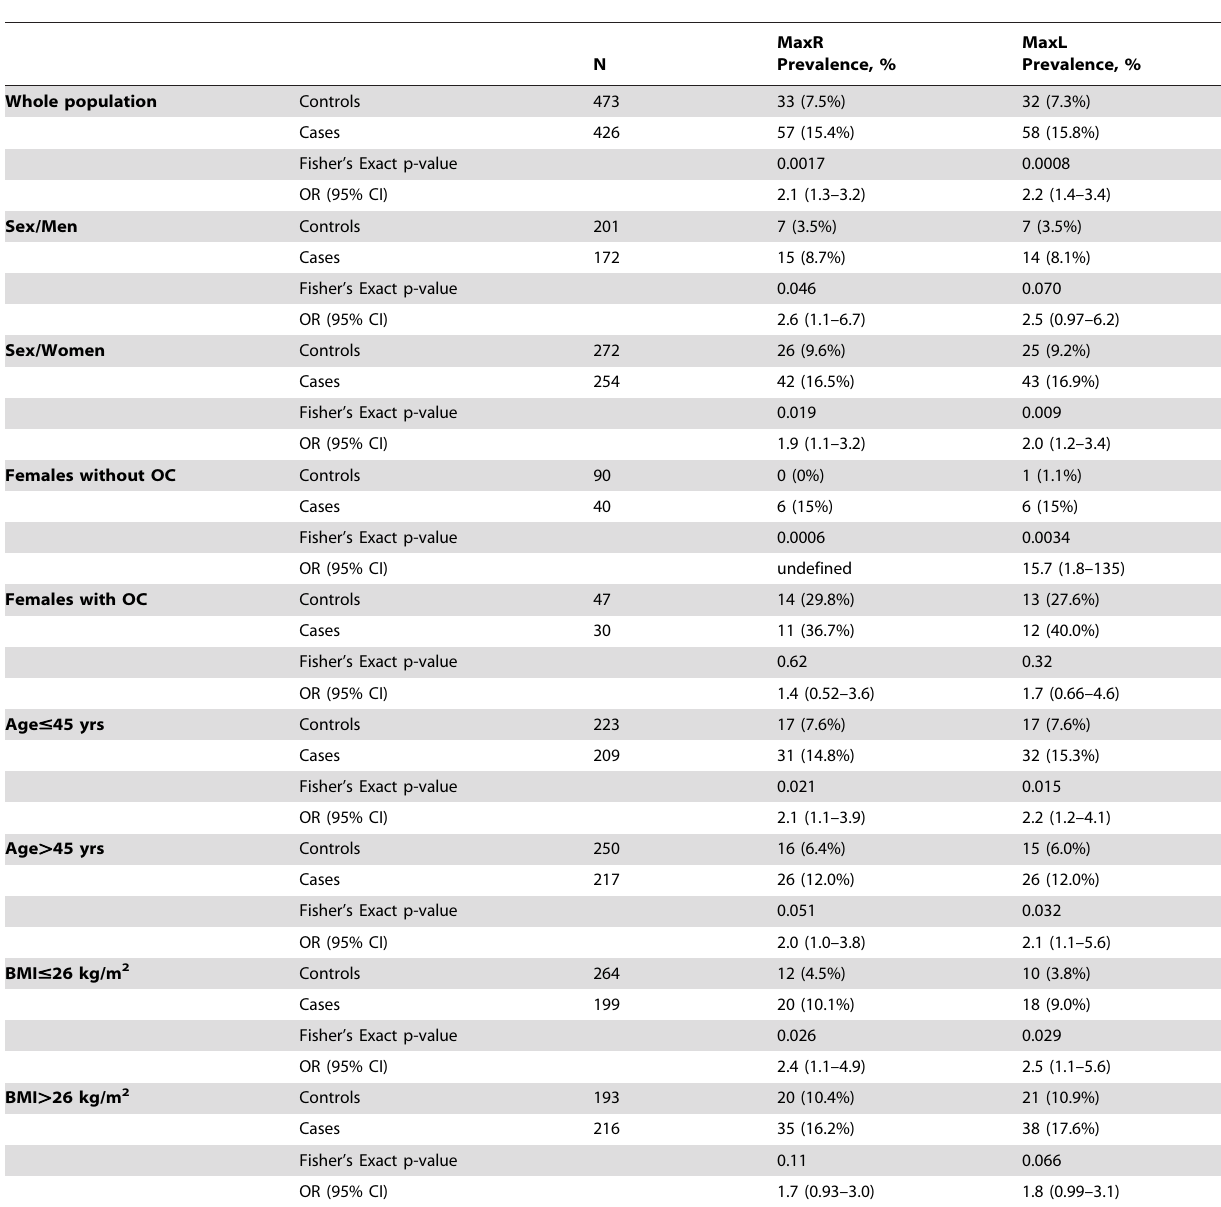
Table 4. Comparison of fXa generation in individuals with a known DVT versus